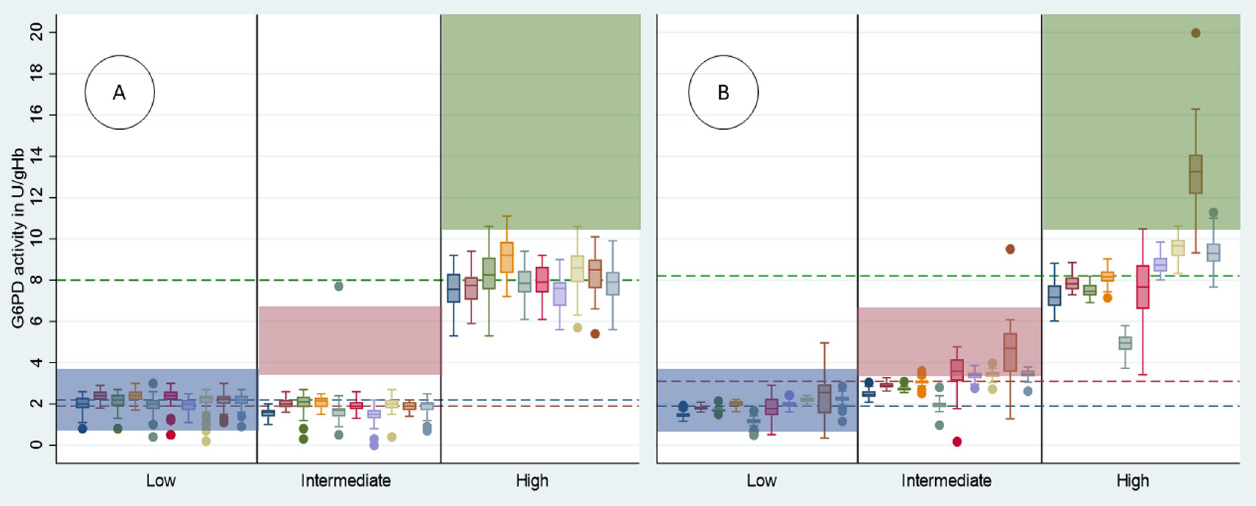
Fig 5. Box and whisker plot of G6PD activity / control by Biosensor (A) and spectrophotometry (B) across Phase B sites. Blue shade = recommended range for ACS Low controls, Red shade = recommended range for ACS Intermediate controls, Green shade = recommended range for ACS High controls, Blue dotted line = median activity of ACS Low controls across all devices, Red dotted line = median activity of ACS Intermediate controls across all devices, Green dotted line = median activity of ACS High controls across all devices, dots represent outliers.